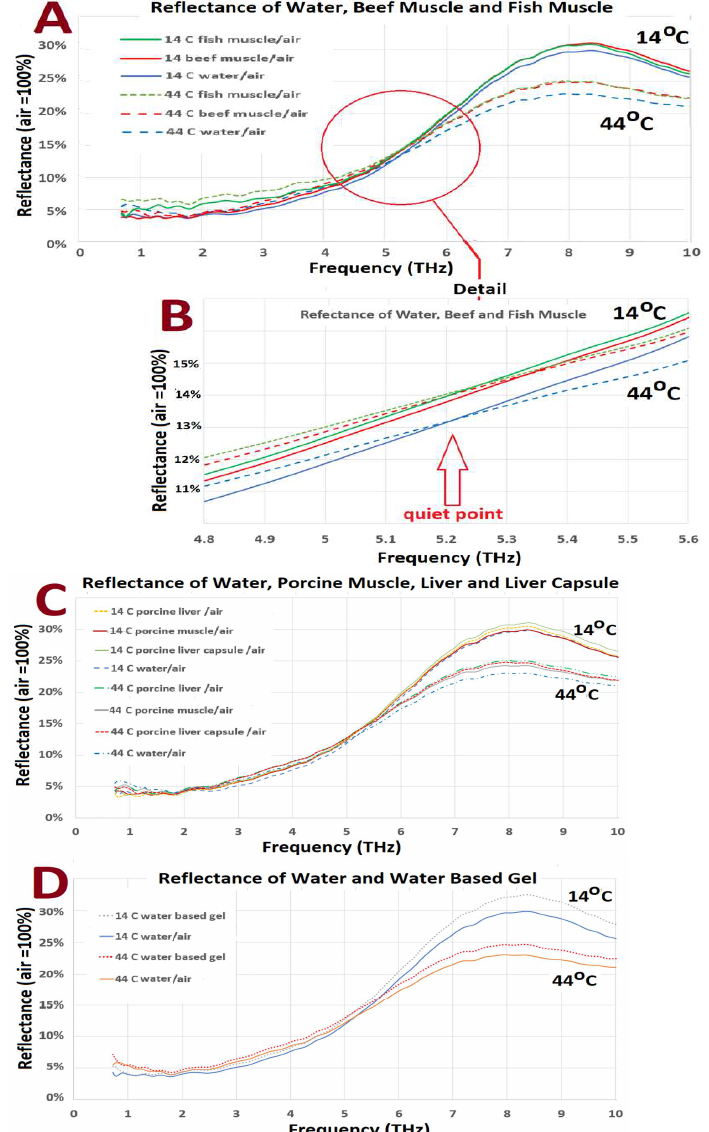
Figure 4. ( A ) The reflectance spectral data for water, beef, and fish muscle. ( B ) Detail of the thermal crossover “quiet point” for water, beef, and fish muscle. ( C ) Spectral data for water and porcine tissues. ( D ) The reflectance data for water-based gel. The frequency for the crossover “quiet point” is similar in all cases. In all cases, the pure water reflectance is lower than that for the tissues. The fish data show a significant divergence from the other tissues in the partial reflection/partial transmission part of the dataset. A widening (“crossover flare”) of the temperature-dependent reflectance range is noted as the spectrum crosses from the refractive-index-dominated zone to the absorption- dominated